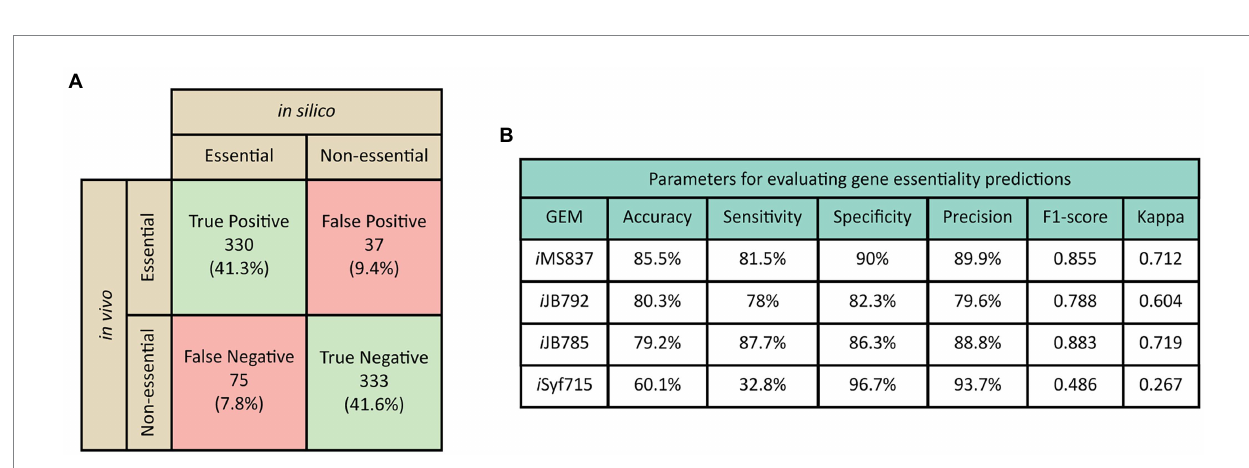
FIGURE 2 Comparison of gene essentially predictions to experimental results. (A) Contingency table of the results obtained for gene essentially predictions using i MS837. (B) Parameters used to estimate the performance of gene essentially predictions for all GEM of Synechococcus elongatus PCC 7942. Gene essentially results obtained in silico revealed a high level of accuracy (85.5%), sensitivity (81.5%), specificity (90%) and precision (89.9%) of i MS837. Genes with ambiguous essentiality results and not-analyzed in vivo were excluded from this analysis (Supplementary Table